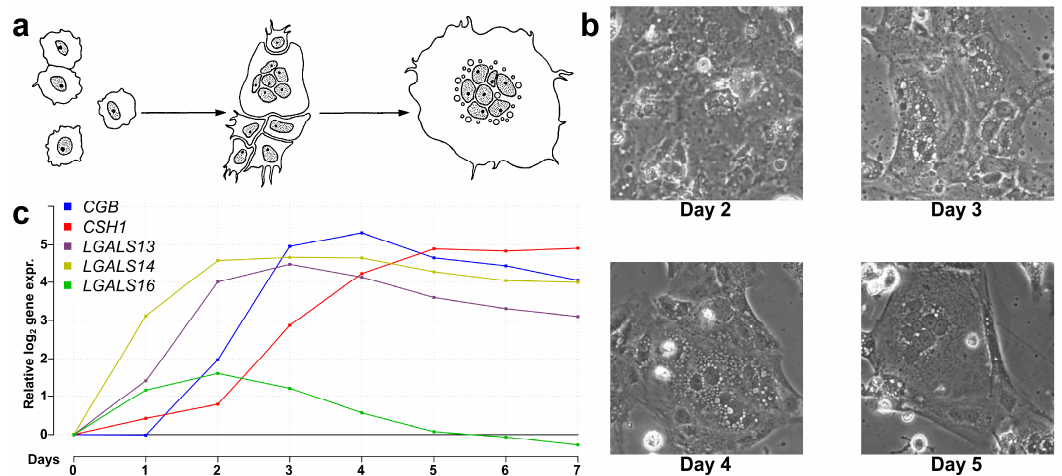
Figure 2. Microarray validation with qRT-PCR. ( a ) Schematic visualization of villous trophoblast differentiation adapted with permission from Hubert et al. [97]. ( b ) Brightfield images (250×) of differentiating and fusing villous trophoblasts on days 2, 3, 4, and 5 of differentiation. ( c ) Line graph showing the relative gene expression change of five genes with predominant placental expression (PPE) from day 0 to day 7 during trophoblast differentiation.